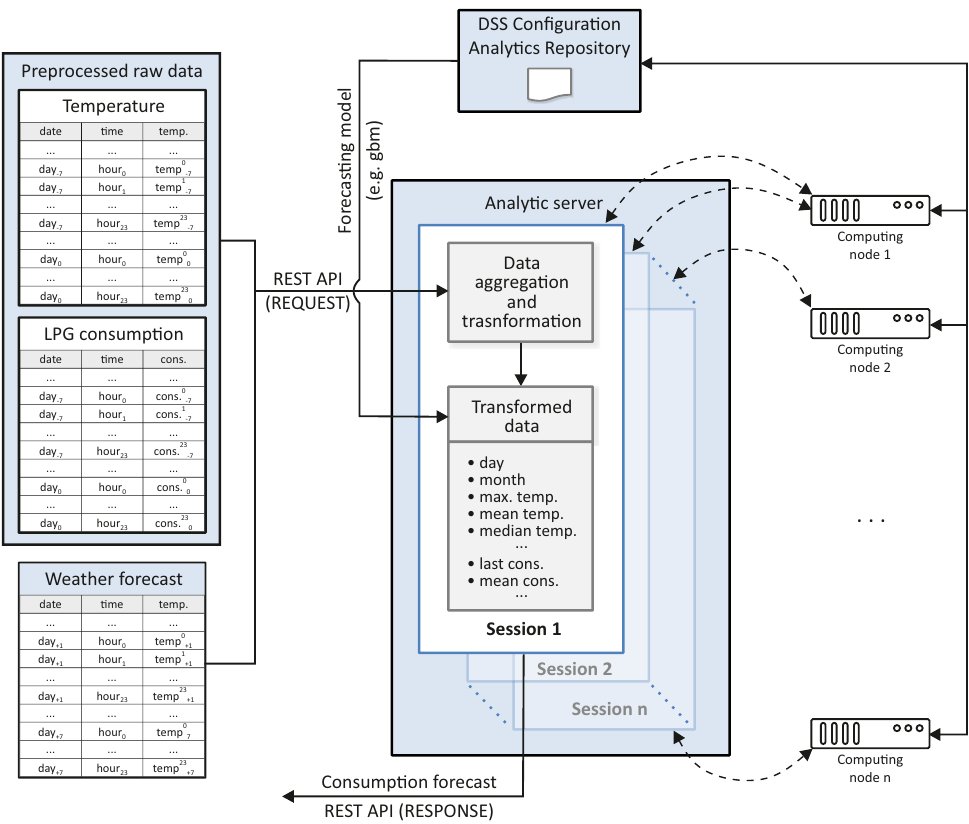
Figure 4. An illustrative example of the analytic server operation—LPG consumption